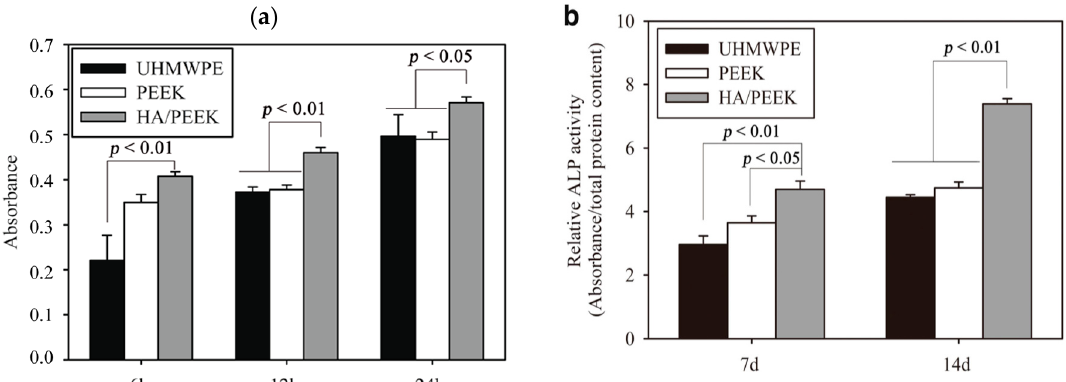
Figure 12. ( a ) Attachment of murine pre-osteoblastic cells (MC3T3-E1) and ( b ) ALP activity of